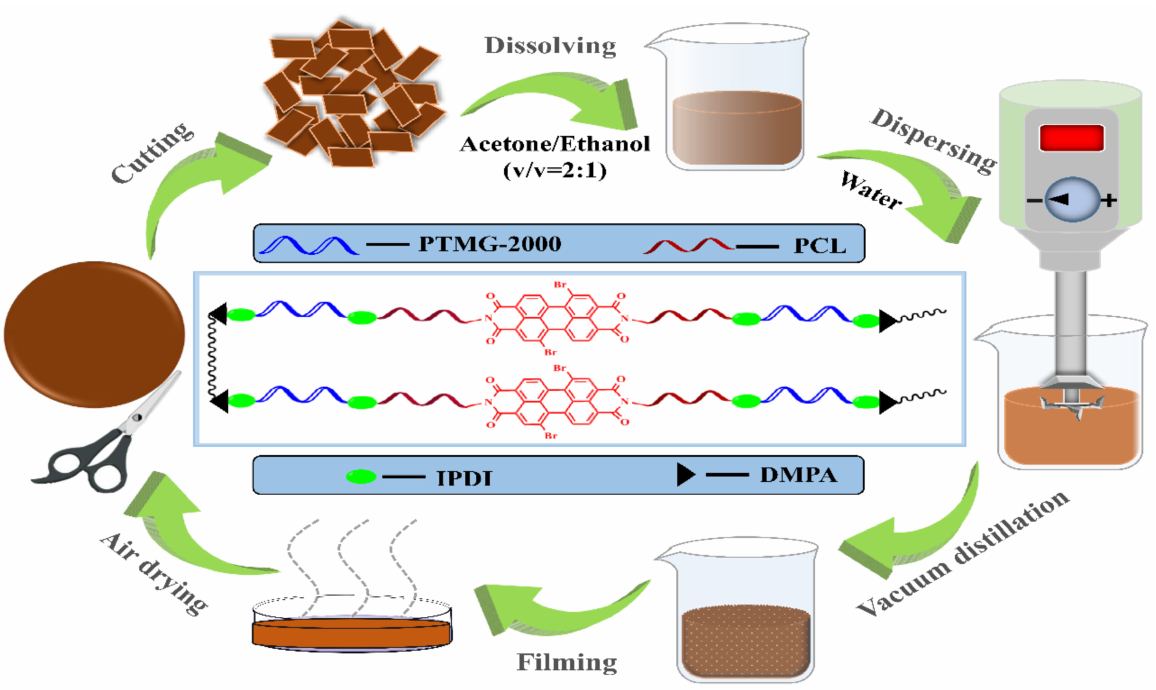
Scheme 2. Schematic diagram of PWPU film